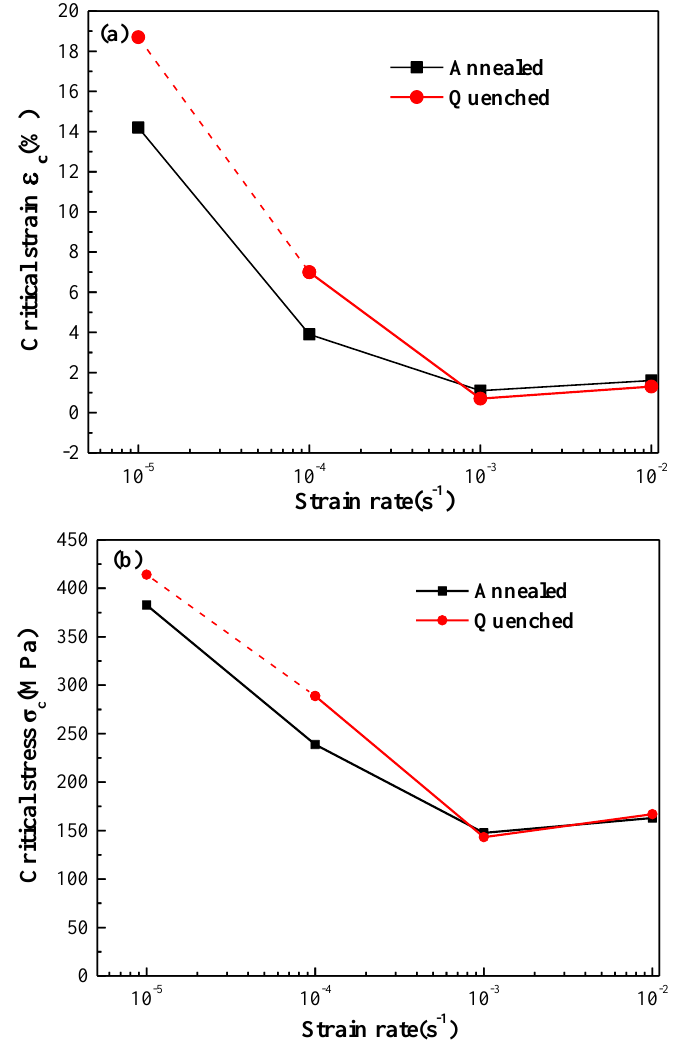
Figure 10 . Relationship between strain rate and ( a ) critical strain ( b ) critical stress of the 5083 Al alloy after different heat treatments.